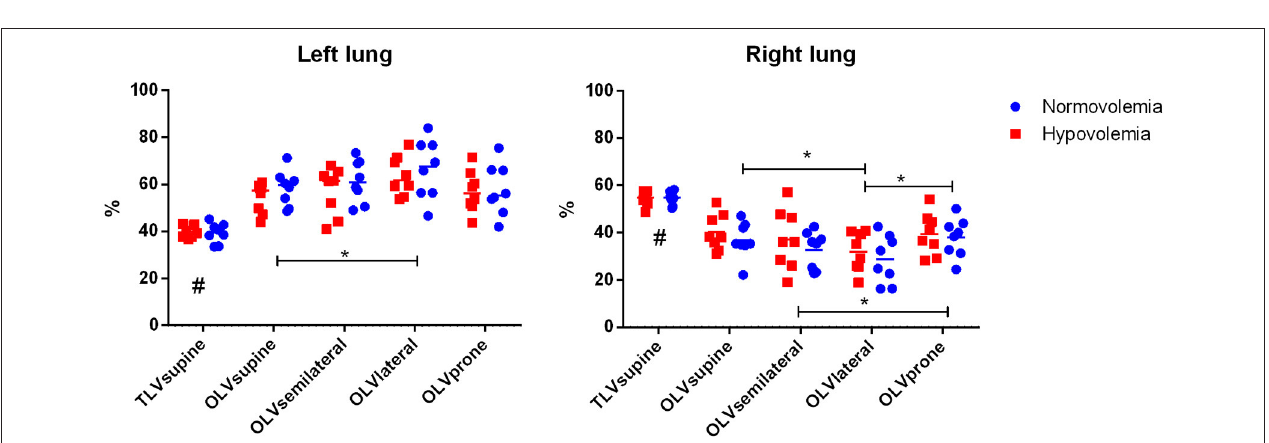
FIGURE 3 | Relative perfusion of the left and right lungs. Mean and single values. Significance was accepted at P < 0.05. Differences between the two groups, respective body positions, and the sequences of interventions were compared using a linear mixed-effects model with repeated measures, with TLVsupine, OLVsupine, OLVsemilateral, OLVlateral, and OLVprone as within-subject factors and with group and sequence as fixed between subject-factors. The significance of the within-subject factors was corrected for sphericity according to Greenhouse–Geisser. Pairwise post-hoc multiple comparisons were performed according to LSD when appropriate. # P < 0.05 TLVsupine vs. all the others, * P < 0.05. The relative perfusions of the ventilated and the non-ventilated lungs were not different between normo- and hypovolemia ( P = 0.457 and P = 0.418, respectively). Mixed effects position × group ventilated lung: P = 0.852 and mixed effects position × group non-ventilated lung: P =